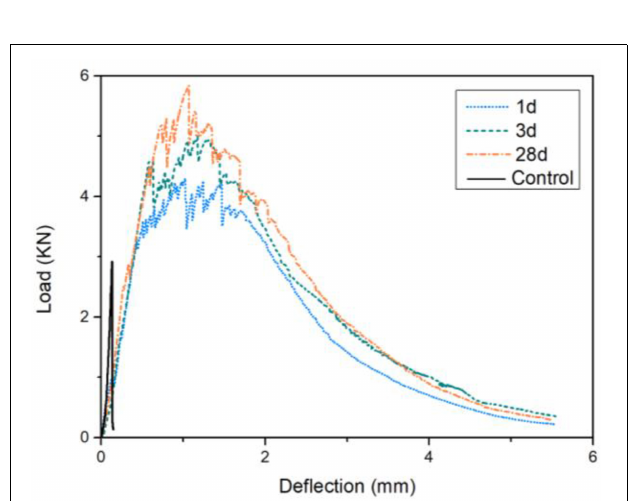
FIGURE 8 | The multiple-cracking behavior of HSHLW-ECCs under (a) flexural strength test and (b) compressive strength test.